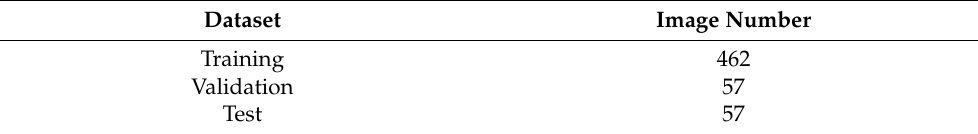
Table 1. The numbers of small images in the training, validation, and testing sets.